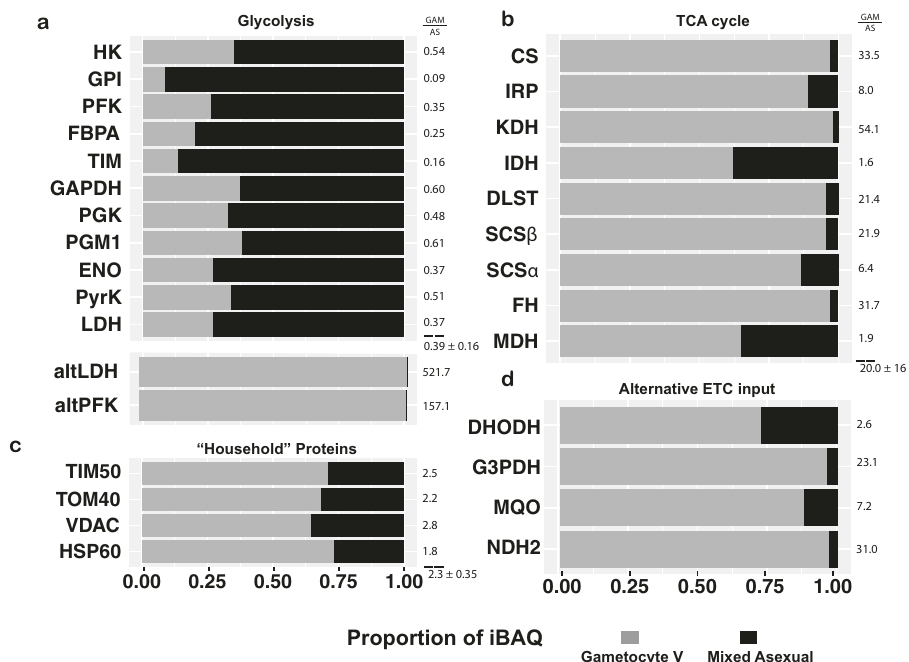
Fig. 7 Abundance comparison of energy metabolism-related proteins. Relative quanti fi cation of a selection of energy metabolism enzymes ( a , b , d ) and mitochondrial household proteins ( c ) in ABS parasites (black) and gametocytes (grey) based on denatured whole-cell lysates separated by SDS-PAGE. Fold changes are indicated next to each bar and averages with standard deviation for a group are indicated below dashed lines. Corresponding Gene IDs can be found in Source